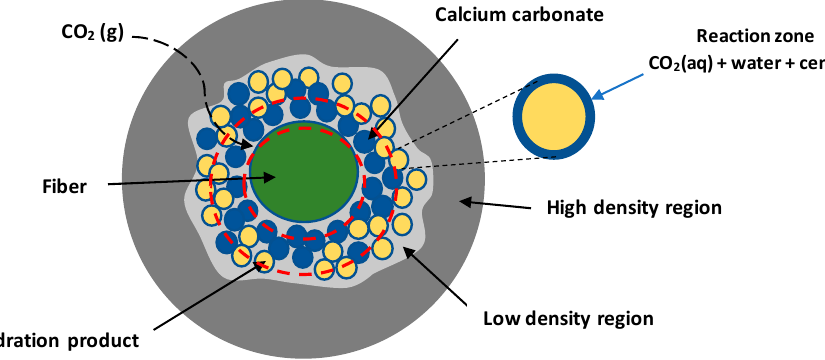
Figure 14. Schematic illustration of the fiber and matrix adapted from [16]—interfacial transition zone (ITZ) is represented by the zone between the two red dashed circles.